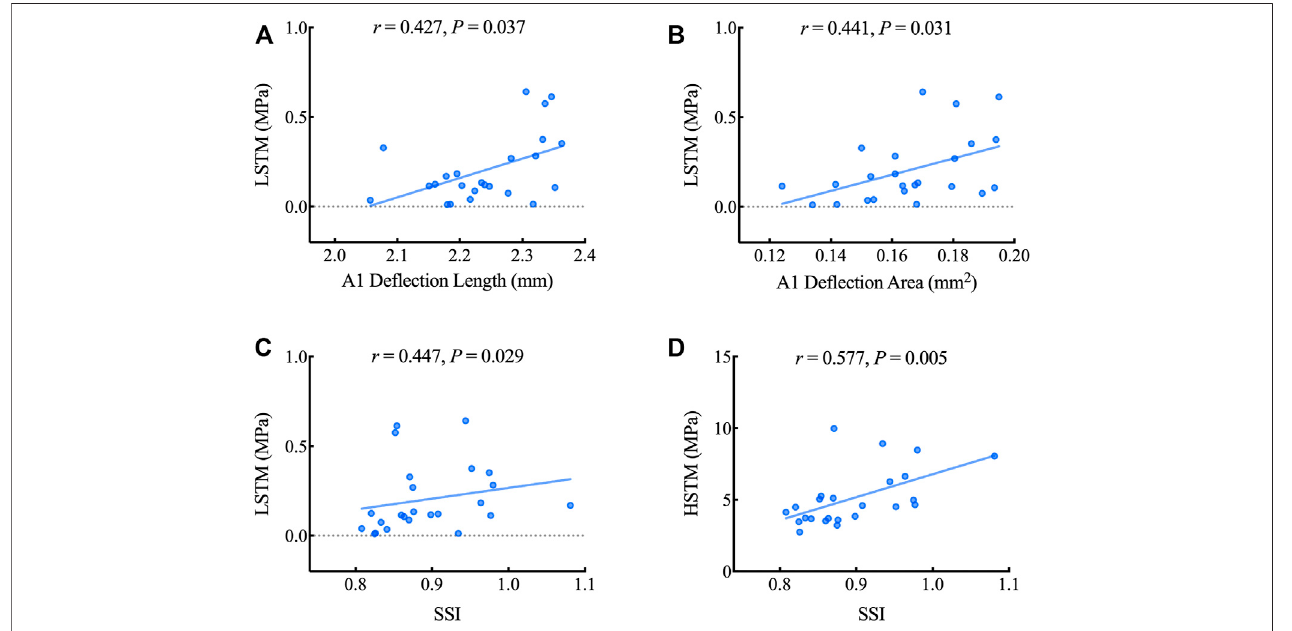
FIGURE 6 | Scatterplots showing the relationship between the LSTM, HSTM and corneal dynamic response and stiffness parameters including A1 de fl ection length (A) , A1 de fl ection area (B) and SSI (C, D) . LSTM: low strain tangent modulus; HSTM: high strain tangent modulus; SSI: stress-strain index.